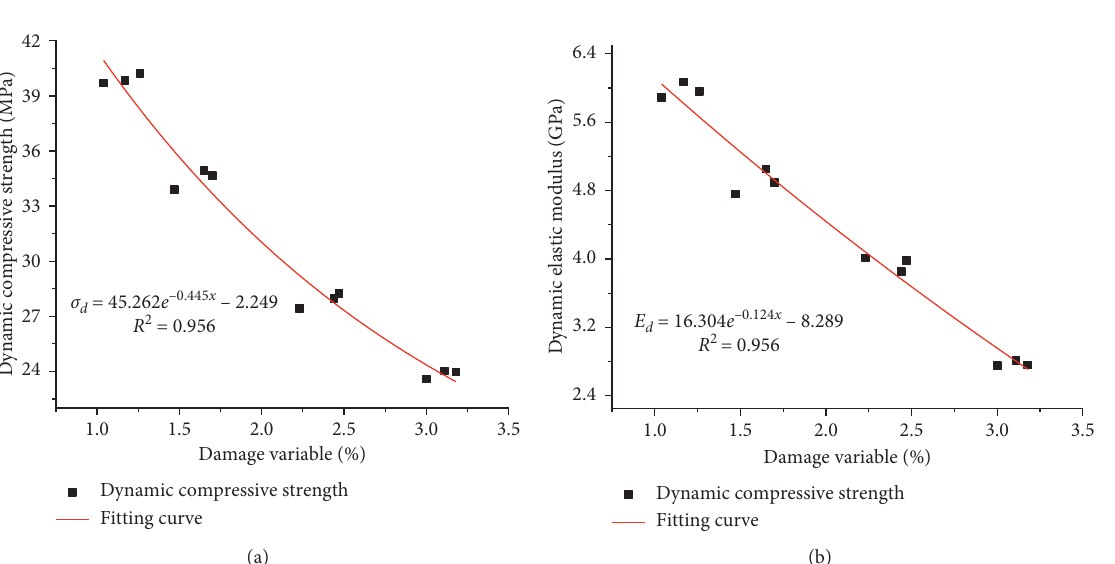
Figure 11: Relationship between damage variables and dynamic mechanical parameters for samples immersed in chemical solutions.